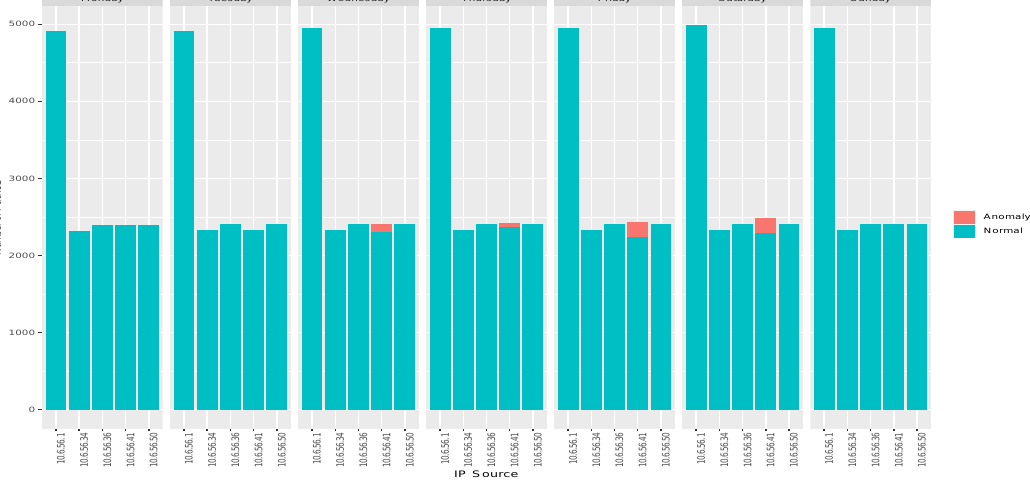
Figure 7. Number of packets by IP source by label and by